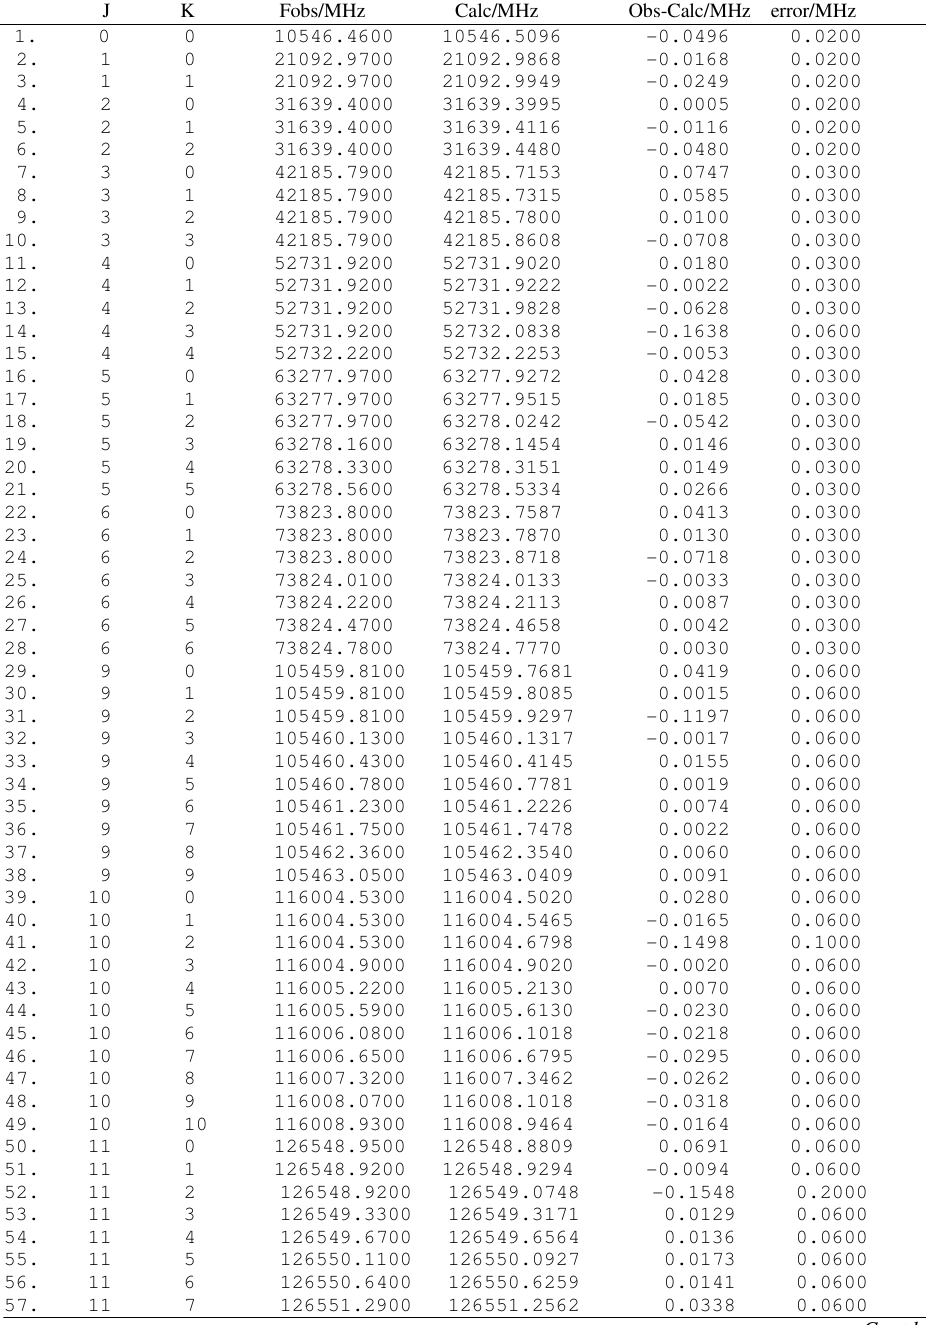
O) in ground 2 3